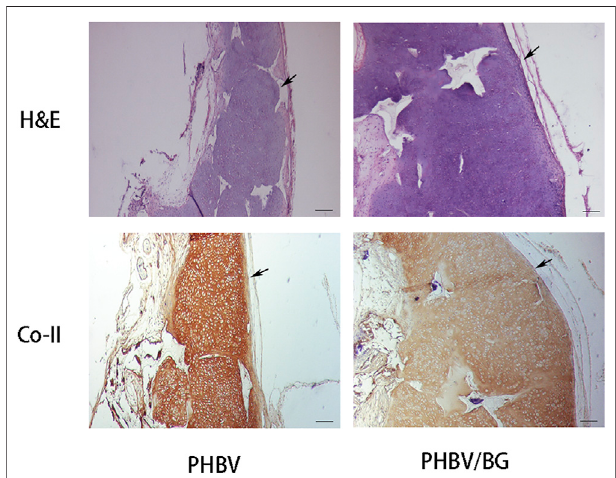
FIGURE 6 | Histological and immunohistological analysis of in vivo engineered constructs. There is an obvious difference in the thickness between the CPC – PHBV/10%Bioglass construct and CPC – PHBV construct ( p < 0.05). The CPC – PHBV/10%Bioglass construct produced